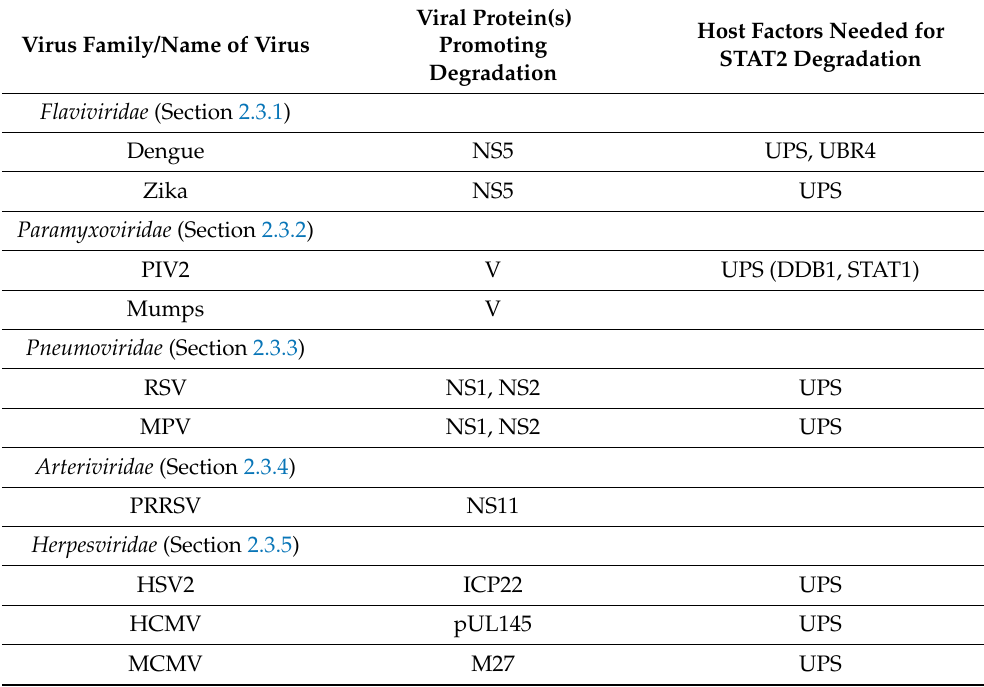
Table 1. Viral subversion of